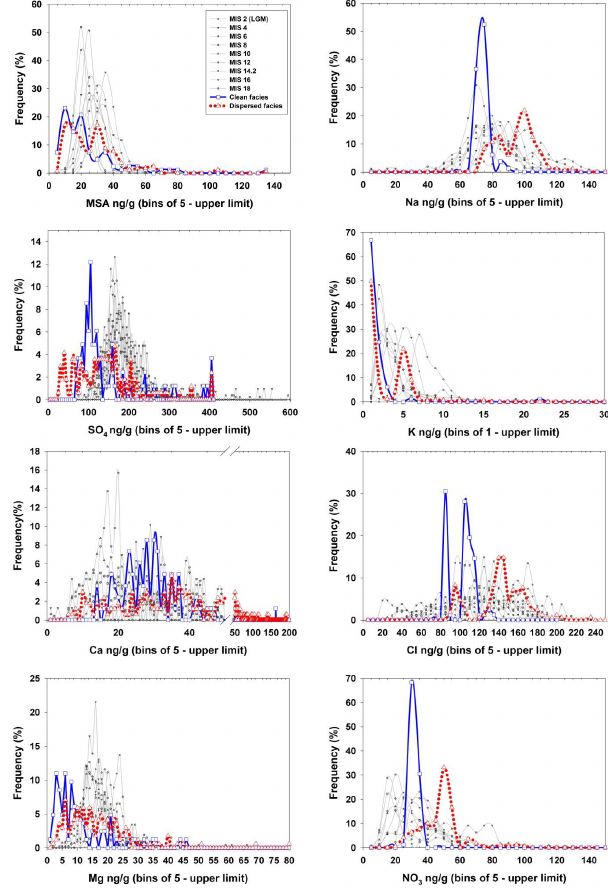
Figure 5. Frequency distribution of concentrations (in bins of 1 or 5ngg − 1 or ppb) of selected chemical species in the clean (open blue squares – thick blue solid line) and dispersed (open red triangles – thick red dotted line) basal ice facies of the EPICA Dome C core, as compared to those for the preceding full glacial periods (incre- mented symbols and thin grey lines – courtesy of EPICA Chemistry Consortium). See text for definition of “full